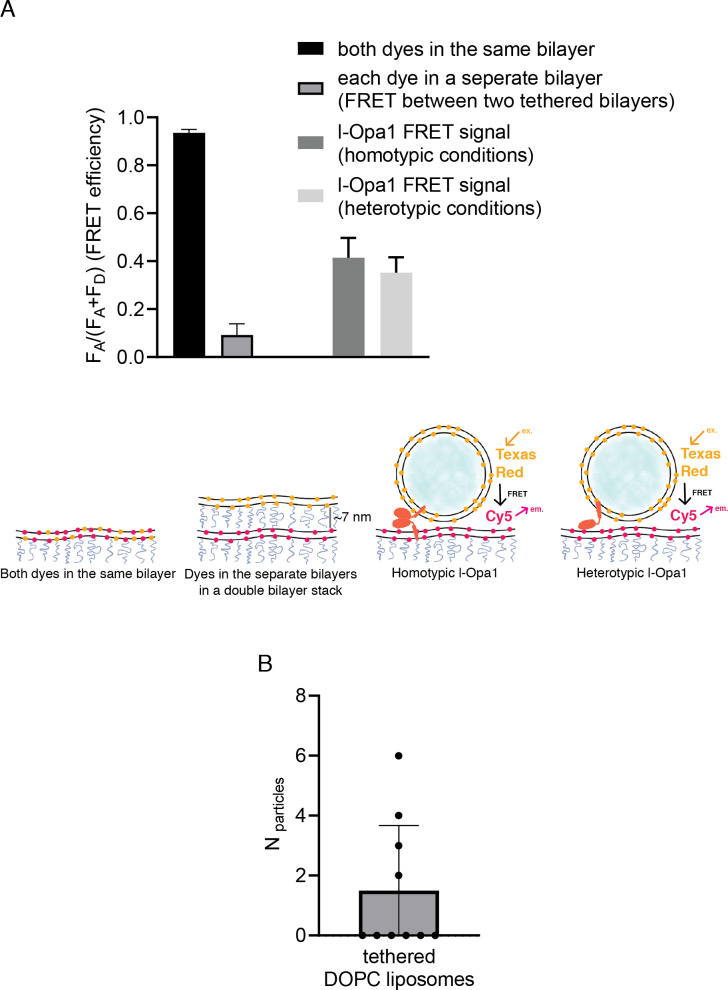
Docking.(A) Controls for intra-membrane and inter-membrane FRET: When both TexasRed and Cy5 PE are present in the same bilayer, high FRET efficiency is observed. When TexasRed and Cy5 PE are present in two different bilayers, with a ~ 7 nm tethering distance (from bilayer center to bilayer center in the double bilayer stack), FRET efficiency was low (data analyzed from 10 random spots in two bilayers (p<0.0001, t test). Analysis of ~20 particles shows ~40% FRET efficiency for both homotypic and heterotypic tethering. This indicates that l-Opa1 is able to bring the two membranes within close proximity (<7 nm) without mixing the two membranes. (B) Quantification of DOPC liposomes tethered to a DOPC bilayer containing reconstituted l-Opa1. Liposomes do not tether to the supported bilayer, indicating that in the absence of cardiolipin, l-Opa1 does not tether liposomes alone. The lack of liposome docking to exposed regions also argues that few defects were introduced into the bilayer following reconstitution. Data from three different bilayers.Figure 4—figure supplement 1—source data 1.Docking.